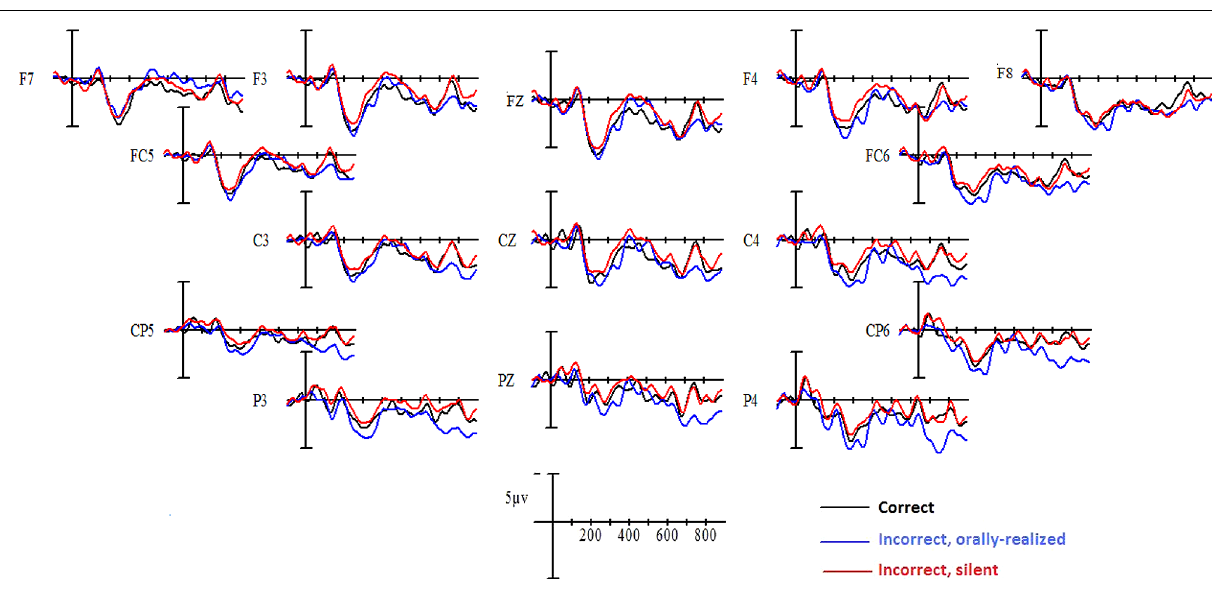
which was modified by Electrode site [ F (4,56) = 3.73, p < 0.03]. At midline, post hoc comparisons revealed that compared to cor- rect cases, orally realized errors elicited a significant P600 response at central ( p < 0.02) and parietal ( p < 0.001) sites, while no signif- icant effect was observed at any electrode sites for silent errors, for any comparison. At lateral sites,a significant effect of Verbal inflec- tionwasobserved[ F (2,28) = 4.27, p < 0.02]whichinteractedwith Site[ F (2,28) = 9.6, p < 0.01]. Posthoc